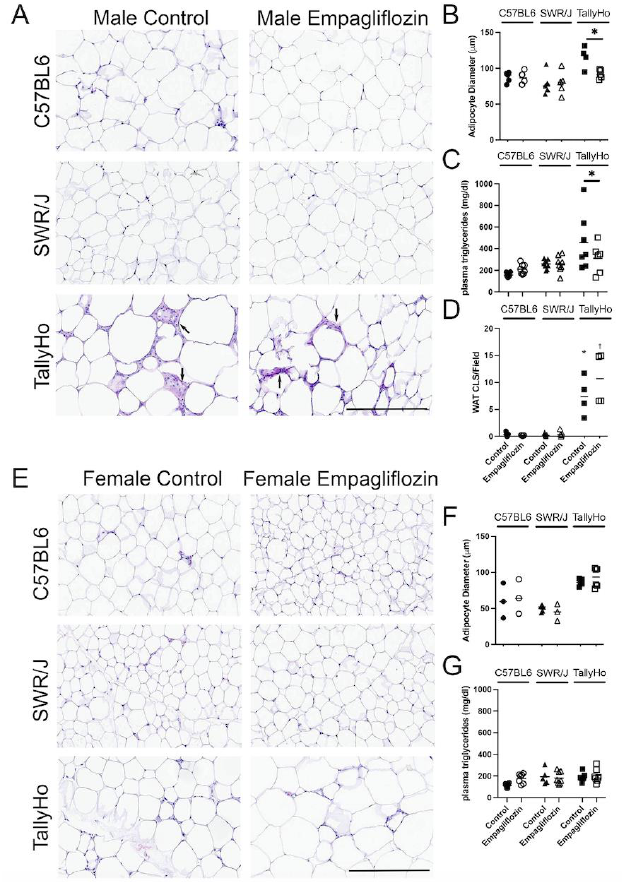
Figure 3. Empagliflozin reduces white adipocyte size and circulating triglycerides in male Tal- lyHo mice. Male and Female TallyHo (squares), SWR/J (triangles), and C57BL6J (circles) were fed a high milk-fat diet in the absence (filled symbols) or presence (open symbols) of 10 mg/kg BW Empagliflozin. The nuchal white fat (WAT) was then isolated and subjected to H&E histological analysis ( A , E ). ( B , F ) Quantification of adipocyte diameter, ( C , G ) circulating triglycerides in male ( B , C ) and female ( F , G ) mice. ( D ) Quantification of macrophage infiltration through the presence of crown-like structures (CLS)/field of view (arrows note CLS). In ( B , C ), Empagliflozin decreased the adipocyte diameter and circulating triglycerides with * p < p = 0.05. In ( D ), both TallyHo control and Empagliflozin-treated male mice had significantly more CLS compared to the control strains (* p < 0.05 TallyHo control mice vs. C57BL6J and SWR/J; † p < 0.05 TallyHo Empagliflozin vs. C57BL6J and SWR/J). Scale bar = 50 µ